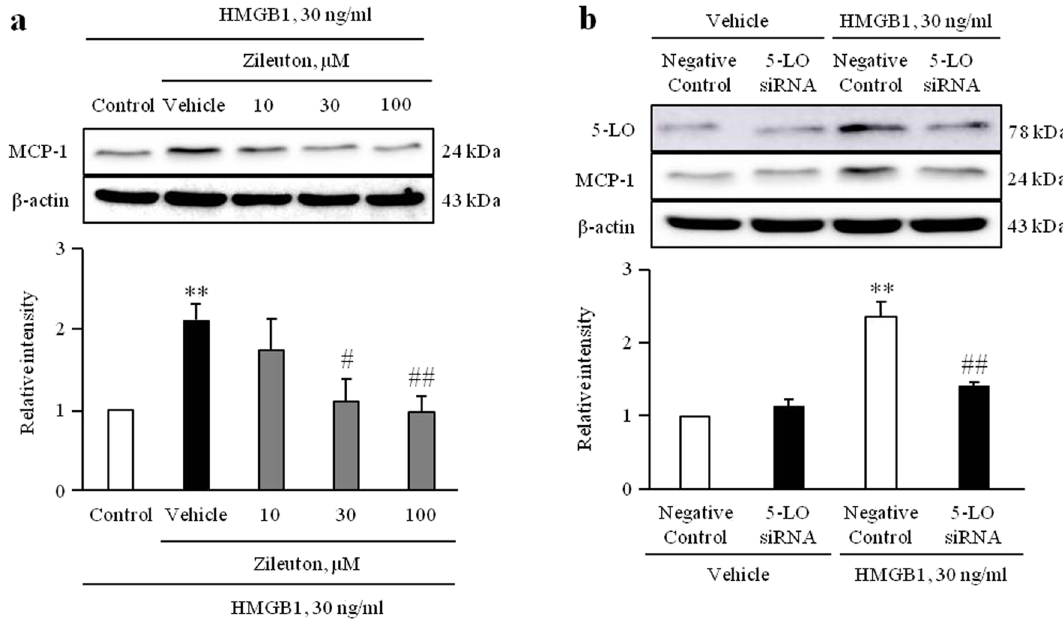
Figure 3. Role of 5-LO in HMGB1-induced MCP-1 expression in VSMCs. ( a ) VSMCs were pretreated with zileuton (0 to 100 μM) for 1 h, and then stimulated with HMGB1 (30 ng/ml) for 48 h. The expression levels of MCP-1 were determined by Western blotting using β-actin as an internal control. Results were expressed as the mean ± SEM of 4 independent experiments. ** p < 0.01 vs. corresponding value in control and # p < 0.05 and ## p < 0.01 vs corresponding value in vehicle. ( b ) VSMCs were transfected with 5-LO siRNA (200 nM) for 48 h, and then stimulated with HMGB1 (30 ng/ml) for 48 h. The expression levels of MCP-1 were determined by Western blotting using β-actin as an internal control. Results were expressed as the mean ± SEM of